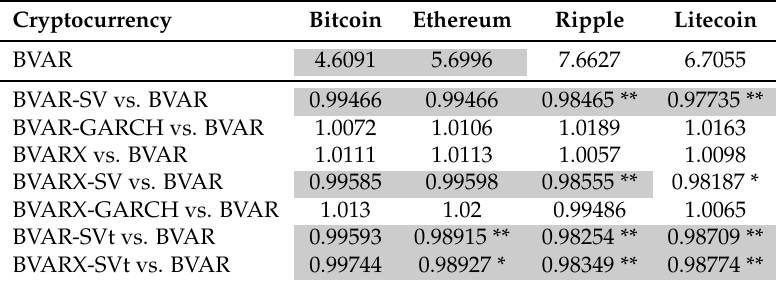
Table 4. Ratio of RMSE against benchmark.